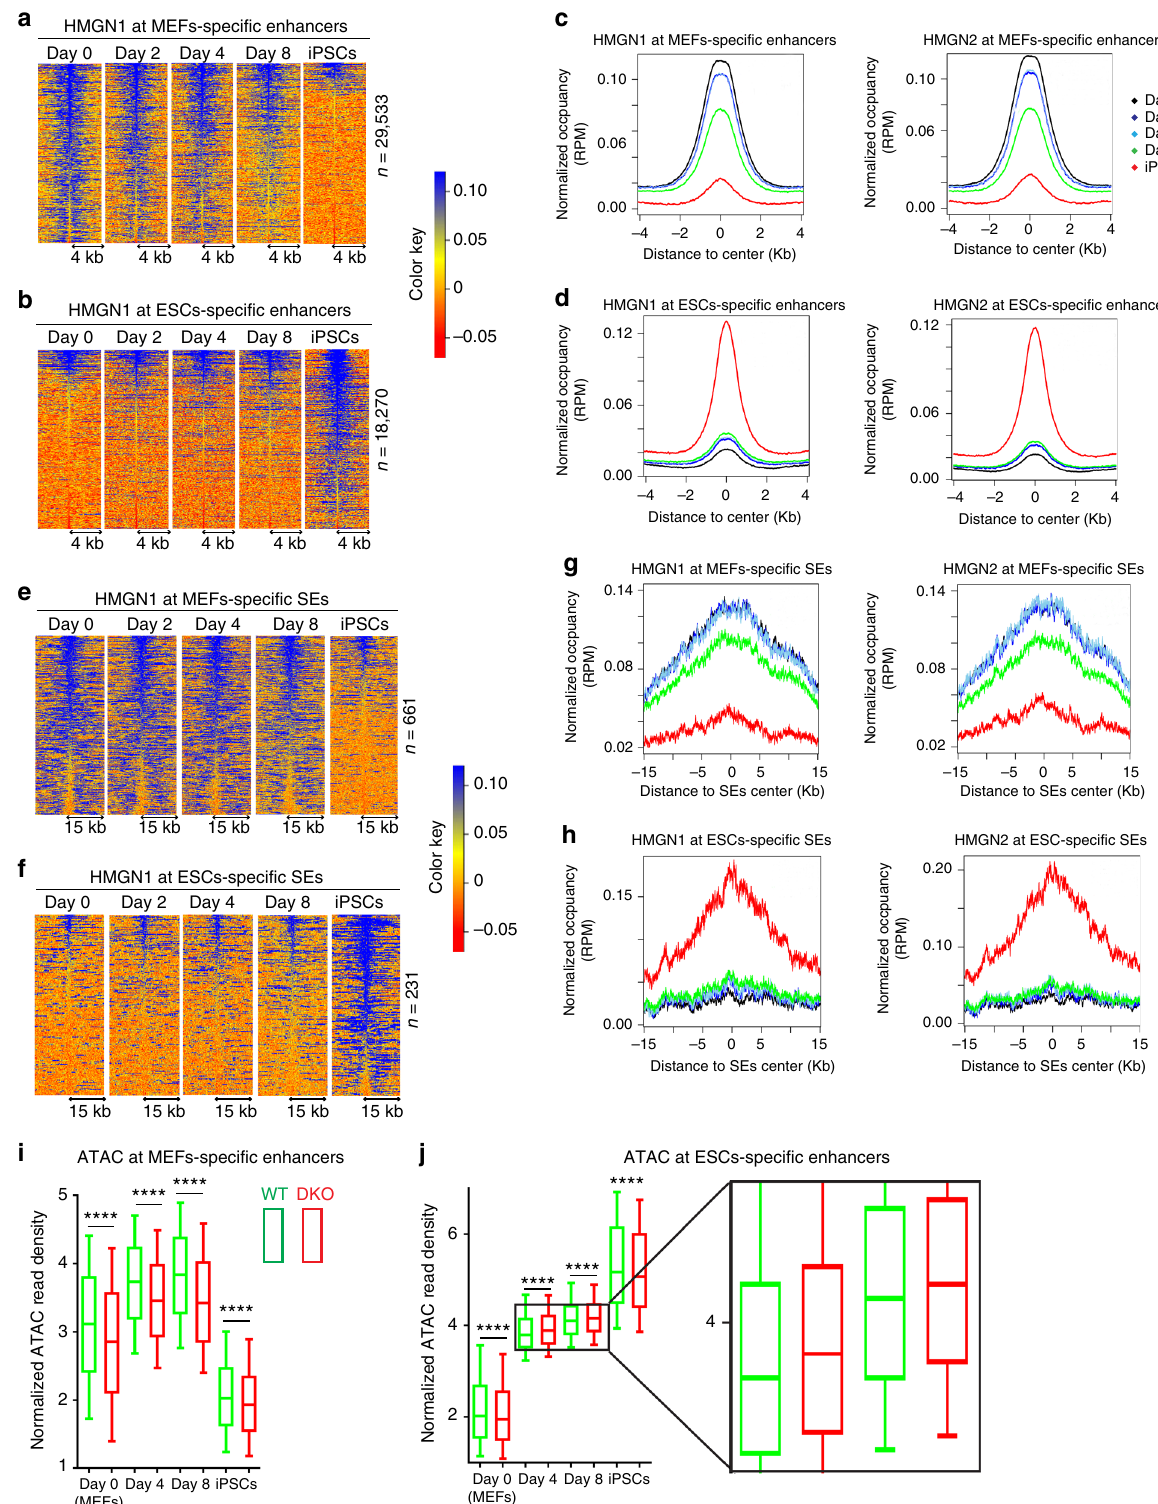
Fig. 3 Relocation of HMGNs from MEFs speci fi c to ESCs speci fi c regulatory sites. Heat maps and occupancy plots of HMGN at MEFs and ESCs speci fi c enhancers ( a – d ) and super-enhancers ( e – h ) during reprogramming. i , j Changes in chromatin accessibility during reprogramming. Box plots of normalized ATAC-seq read density at MEF- and ESC-speci fi c regulatory sites during the reprogramming of MEFs to iPSCs. The whisker line represented the 10-90 quantiles of read density for all the regions. Signi fi cance between DKO and WT groups across all the regions was determined using a two-sided paired Wilcoxon rank-sum test. Each point is average of 3 biological replicates. ****p <